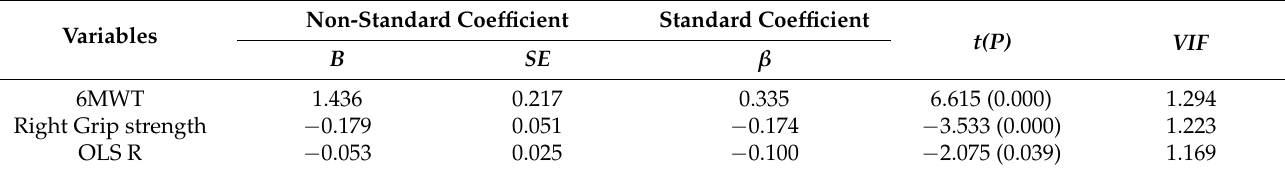
Table 5. Association between fall risk factors and fall efficacy ( n = 393).